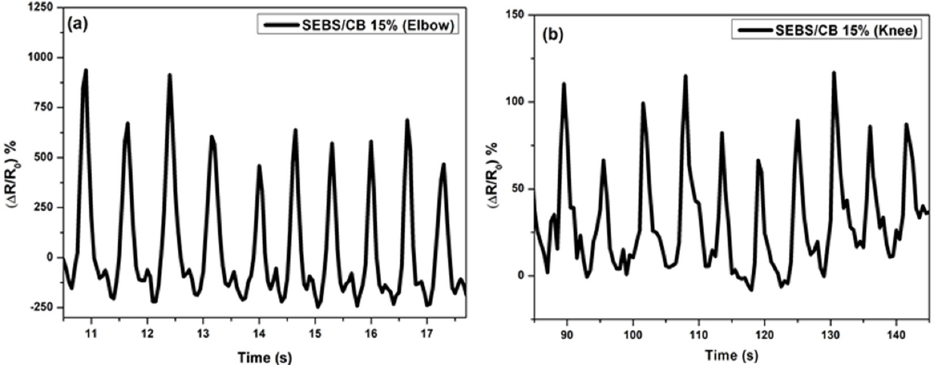
Figure 12. Change of resistivity vs. time for walking sensors: ( a ) elbow response and ( b ) knee response. The responses were measured simultaneously.